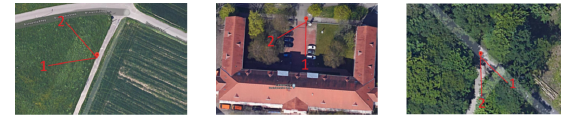
Figure 5. Testsites 1-3 with directions